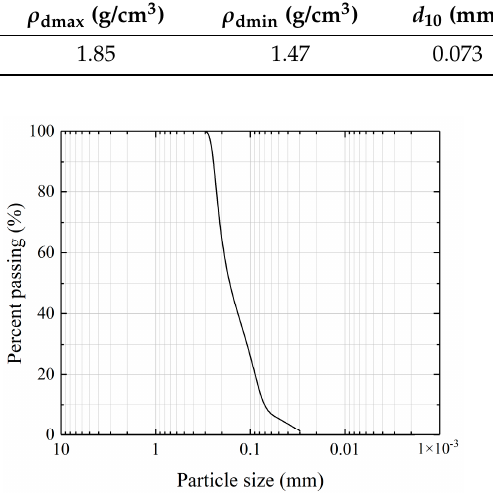
Table 1. Physical properties of aeolian sand.